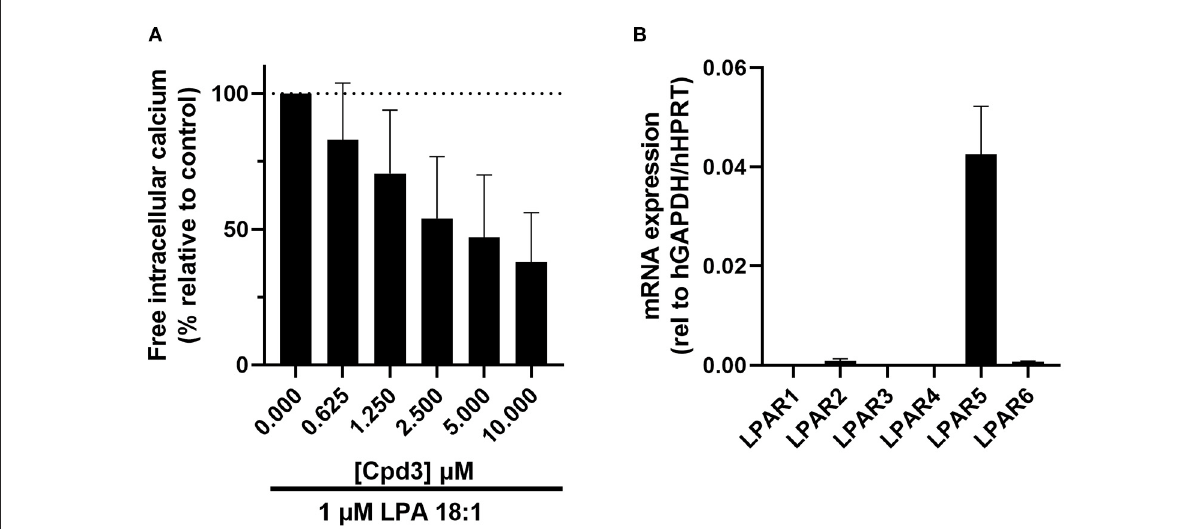
FIGURE1 (A) Increase of free Ca 2 + in HMC-1 cells, induced by 1 µ M LPA 18:1, was dose-dependently inhibited by cpd3 (maximal DMSO (vehicle) concentration 0.1%). Expressed in percentage of delta ratio relative to control (B) mRNA expression of LPA receptor 1-6 ( LPAR1-6 ) in HMC-1